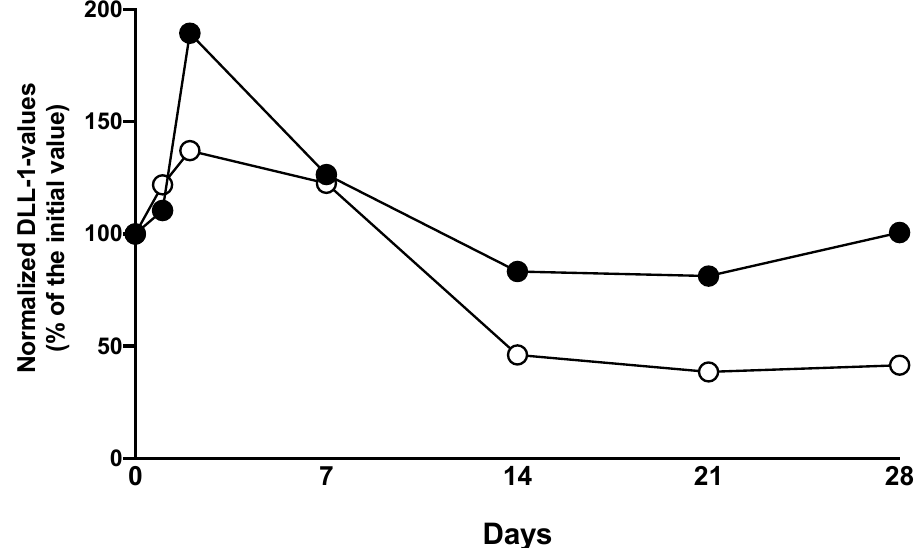
Figure 3. Percentage changes of Delta-like Canonical notch ligand 1 (DLL1) for the recognition of a bacterial infection following liver transplantation (LTX). Plasma concentrations of Delta-like Canonical notch ligand 1 (DLL1), given as normalized values to the initial plasma levels at day 0 following LTX for patients with bacterial infections (black dots) and without bacterial infection (white dots). Values are presented in percent.